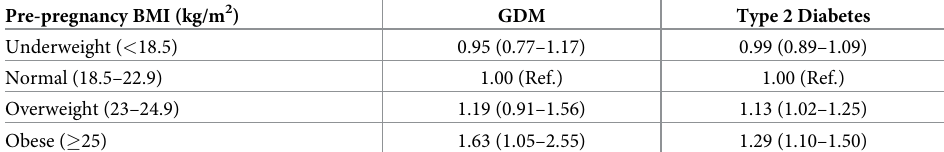
Table 2. Associations of pre-pregnancy BMI with GDM and type 2 diabetes in the Health Examinee Study (HEXA) 2004–2013.